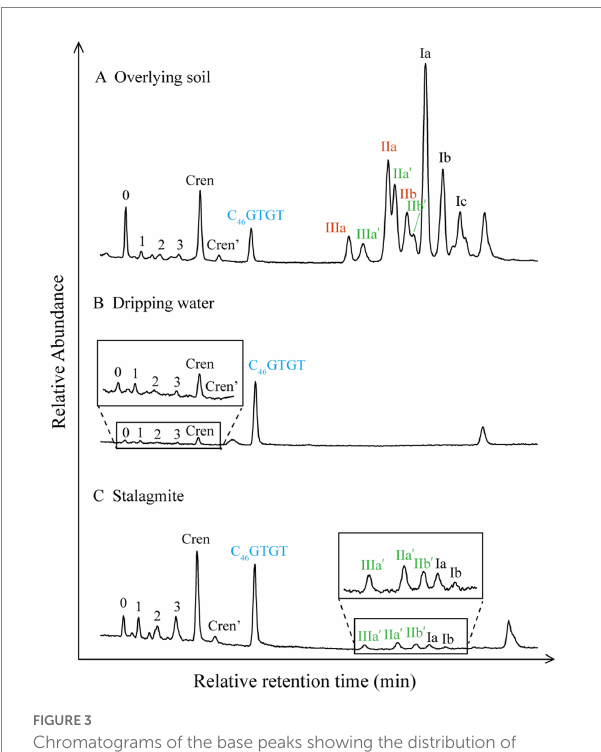
FIGURE 3 Chromatograms of the base peaks showing the distribution of GDGTs in overlying soil (LBT-1), dripping water (HS4D-4), and stalagmite (HS4-2) (data from Heshang Cave, Zhang et al.,